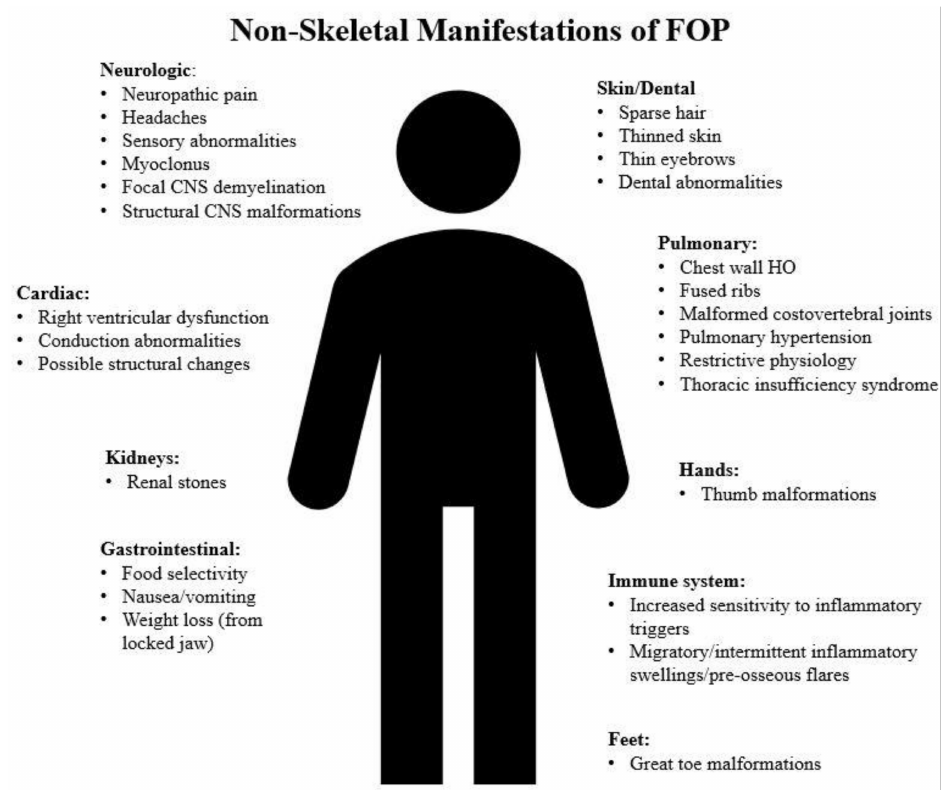
Figure 1. Major non-skeletal manifestations of Fibrodysplasia Ossificans Progressiva (FOP). The hand and foot malformations are also listed, as they are strongly correlated with the diagnosis of FOP. Other skeletal malformations are summarized in Table 1